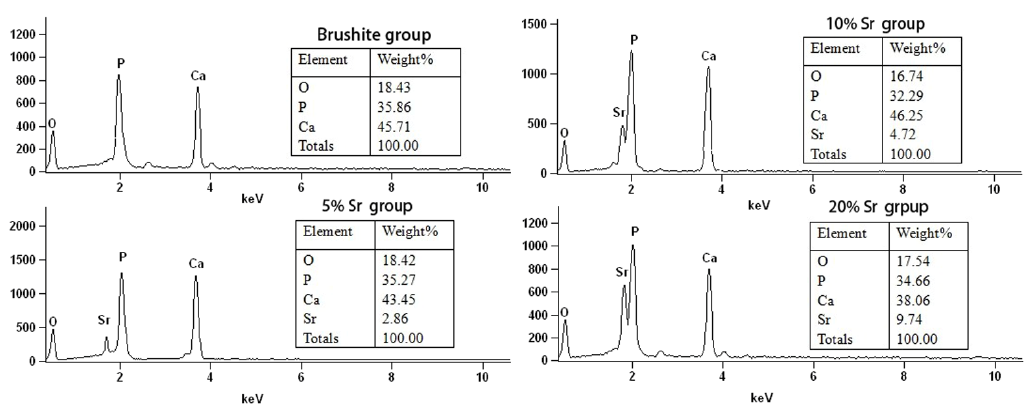
Figure 3. Coating element analysis using energy dispersive X-ray spectroscopy